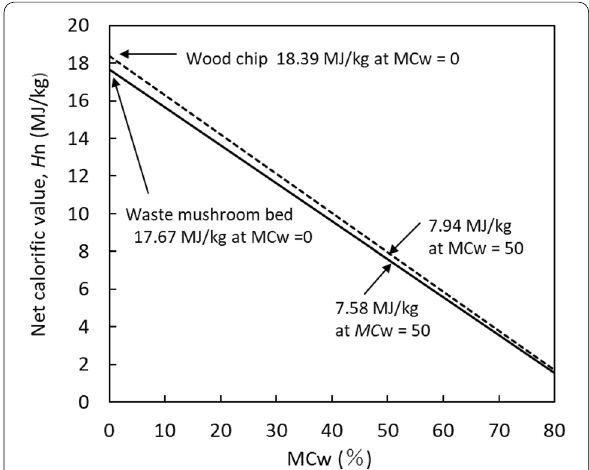
Fig.6 Relationships between moisture content on a wet basis (MC w ) and the net calorific value for both the waste bed (whole) and the original wood